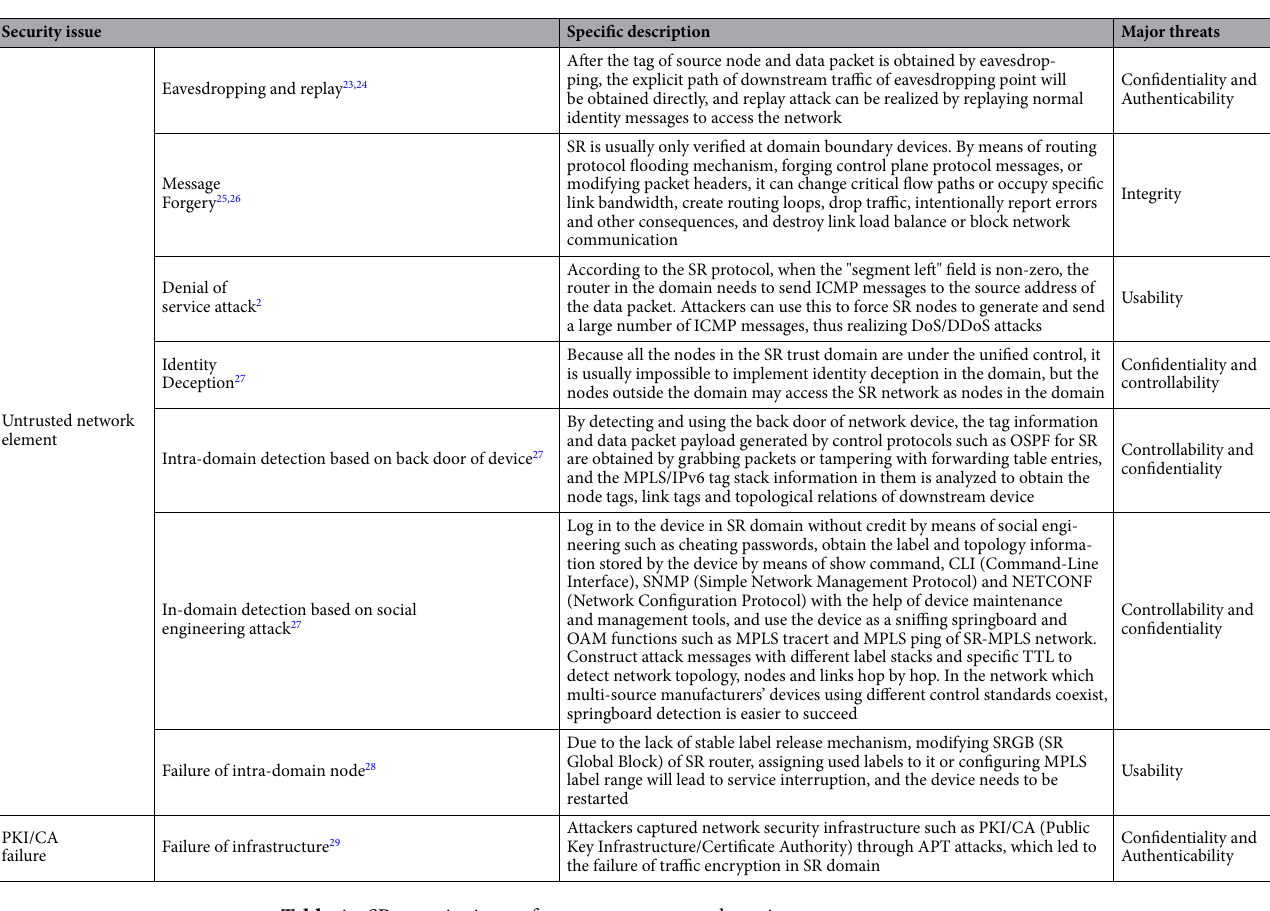
Table 4. SR security issues for zero-trust network environment.